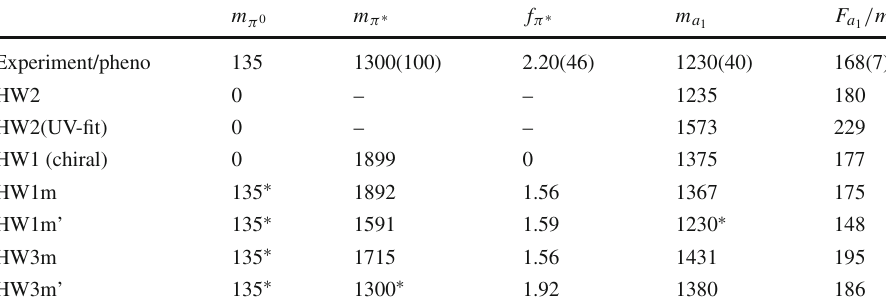
Table 1 Masses and decay constants in the axial sector in MeV, compared with experimental masses according to PDG [96] and phenomenological values for / m f π ∗ and F a a 1 from [97,98], 1 respectively. (Our definition of F a m A and corresponds to F a = 3 √ A 1 F a = 3 m A / 2 in [57,98,99], A respectively.) Fitted values are marked by a